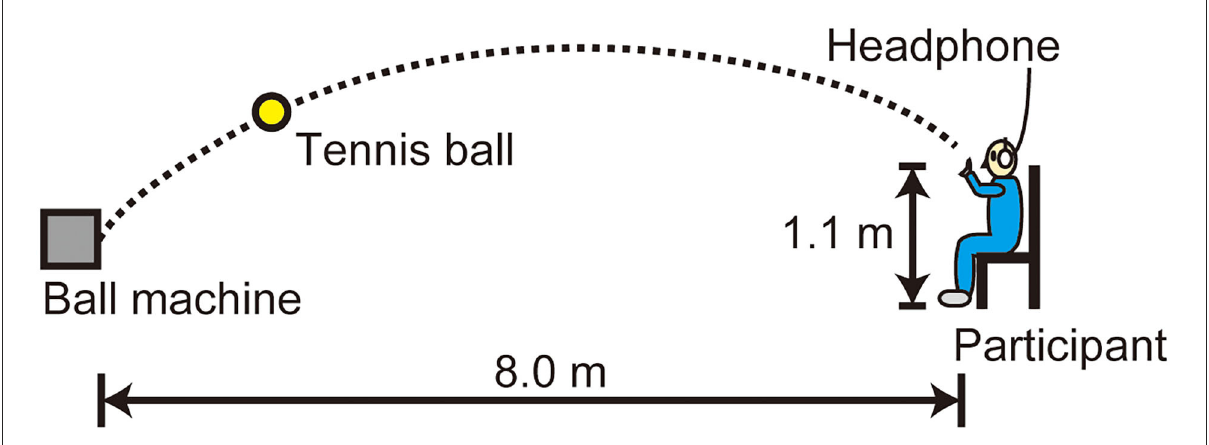
FIGURE1 Setup of the PR experiment. The participants caught a ball projected from an automatic feeding machine with their non-dominant (left)